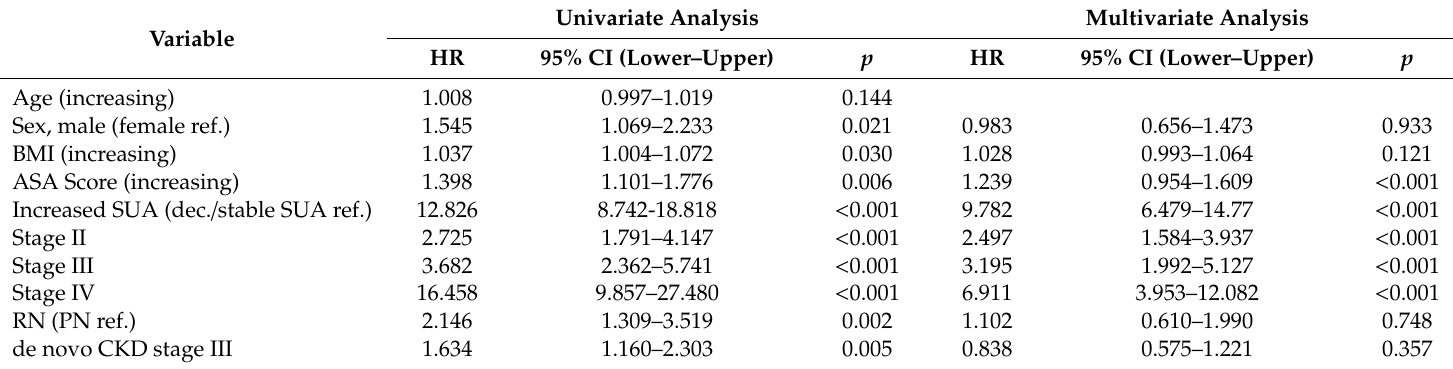
Table 6. Cox proportional hazard analysis of prognostic factors for recurrence free